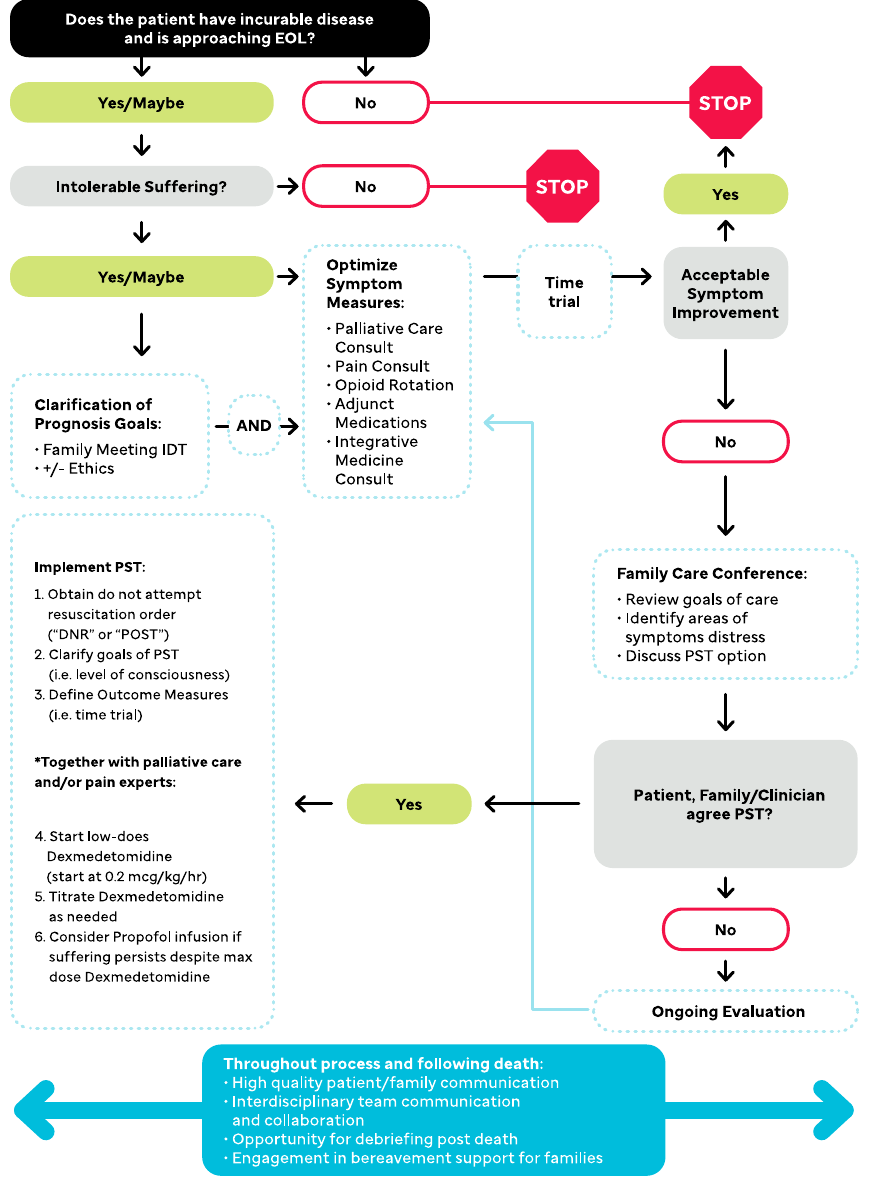
Figure 1. Algorithm for initiation of palliative sedation therapy (PST) * Maximum dosing for dexmedetomidine and starting dose recommendations for propofol not provided due to differences in physician prescribing patterns and influence of institutional policies on dosing. Previous author experience reports initiation of propofol at 30 mcg/kg/min